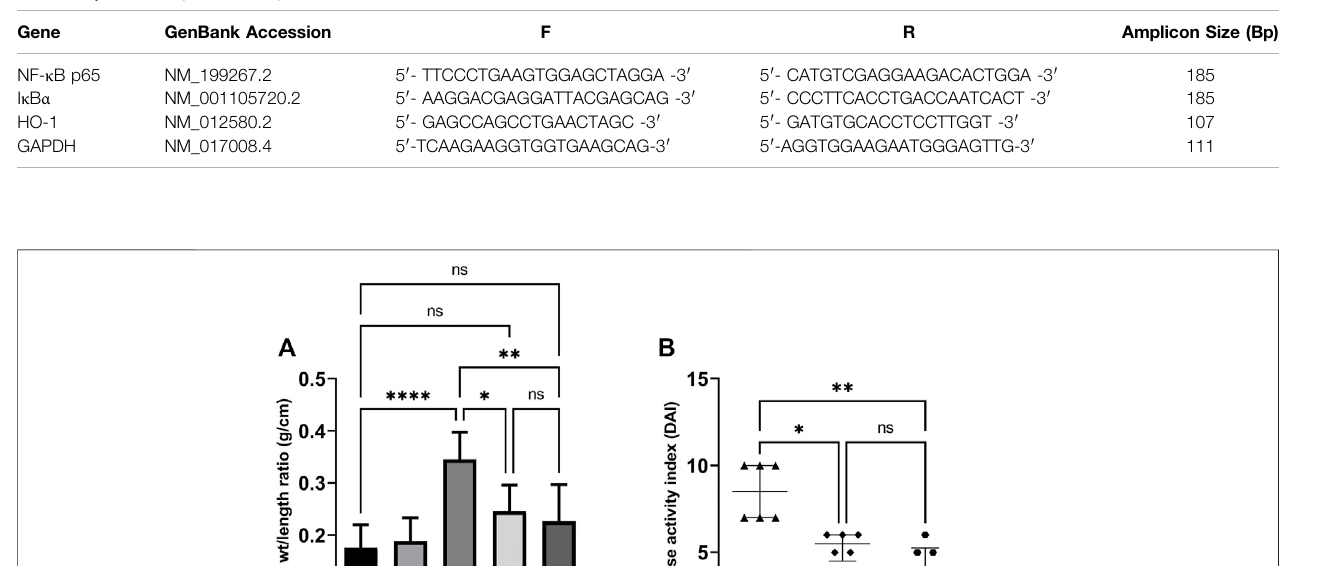
Frontiers in Pharmacology |